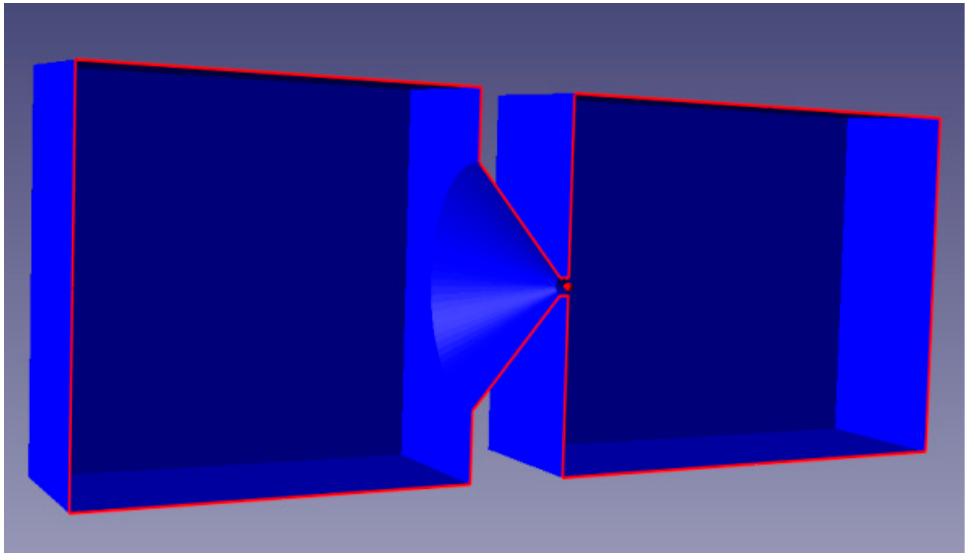
Figure 2. Calculation model of A. Stodola (hole with a sharp edge).